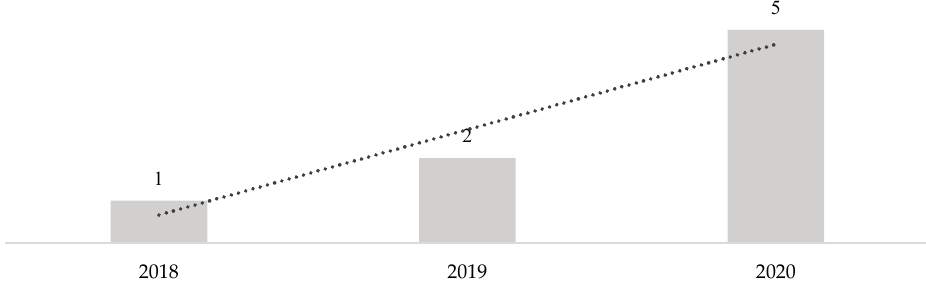
Figure 2. Total number of the studies included and growing trendline.